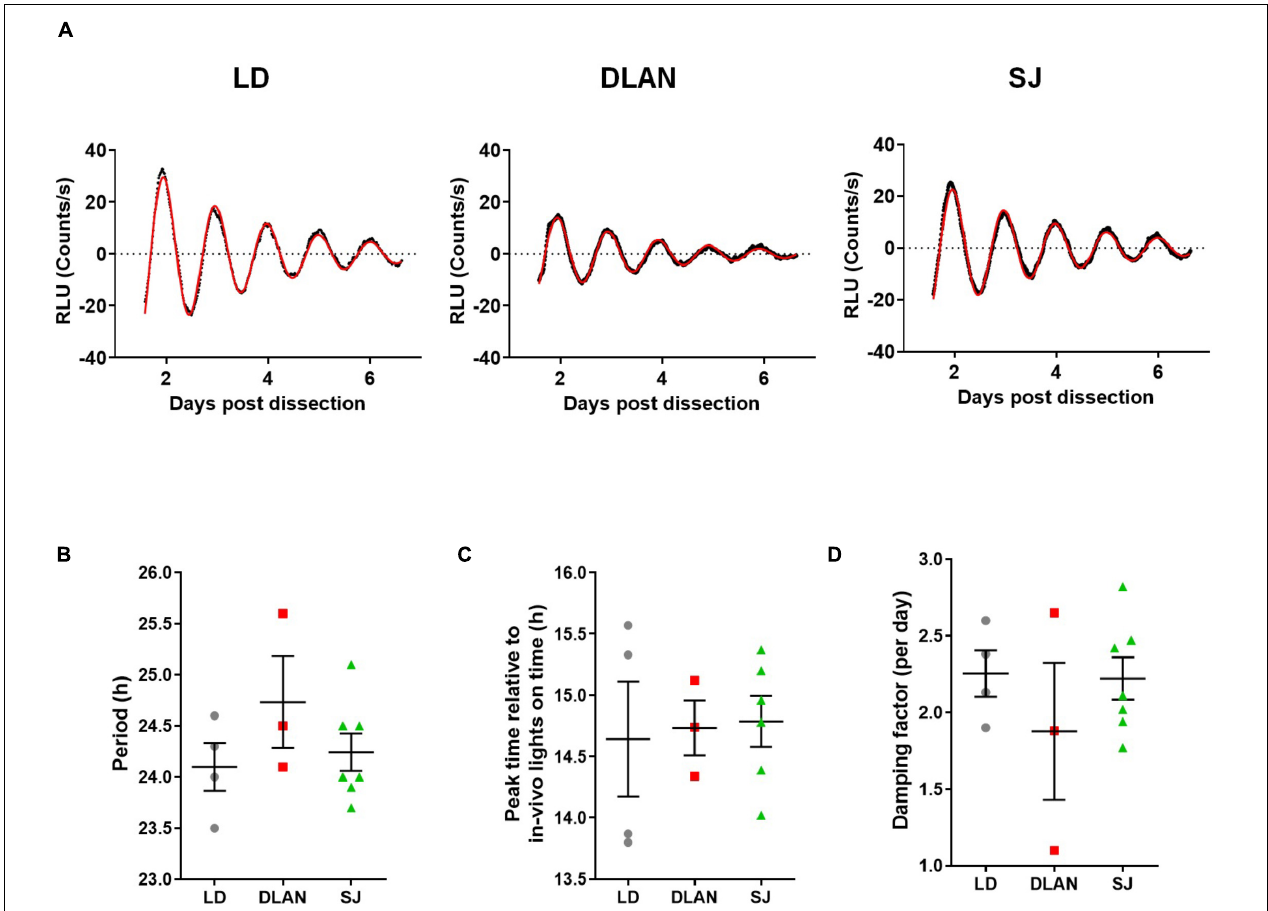
FIGURE 5 | Ex-vivo bioluminescence of the SCN of mice, following the 12-month light disruption protocol. (A) Representative bioluminescence traces are shown for each of the experimental groups. The black line represents the actual data, and the red line represents the best fit line, using a damped sine fit. From these data, the period (B) acrophase (C) and damping rate (D) are shown. Individual data points represent independent SCNs and group means ± SEM are presented. One-way ANOVA (with Welch correction when appropriate), groups: LD, DLAN, SJ. Post-hoc tests conducted with Benjamini-Hochberg corrections when appropriate.